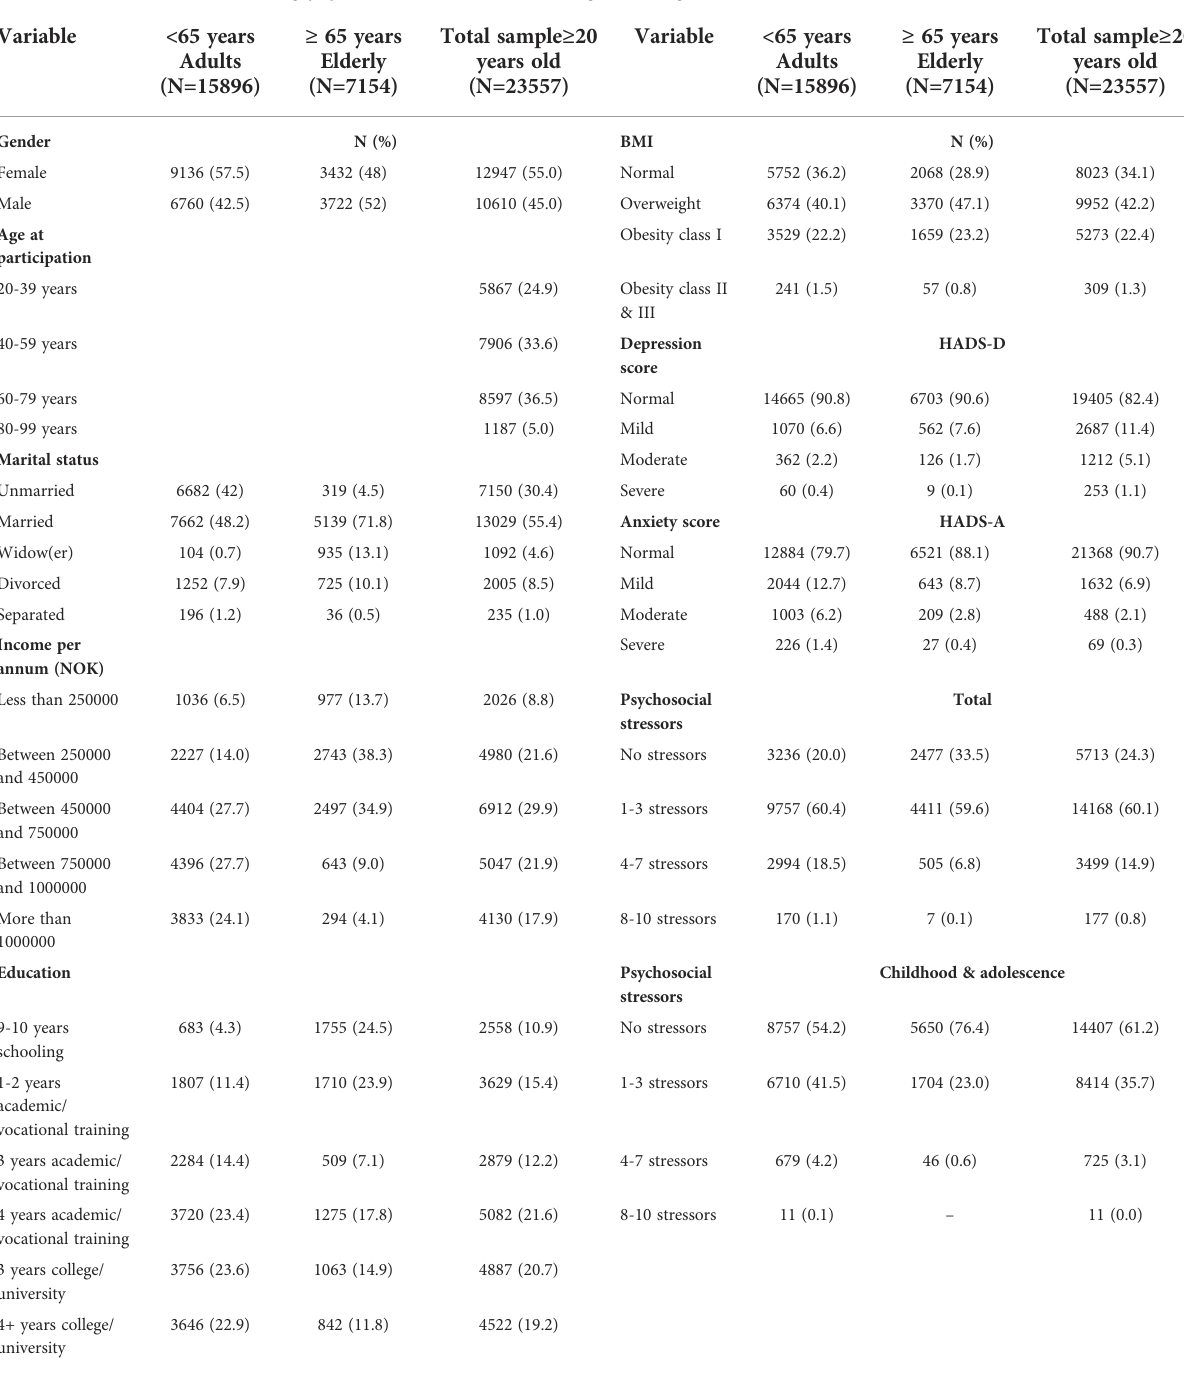
TABLE 1 Characteristics of the study population from the HUNT4 survey in Norway.